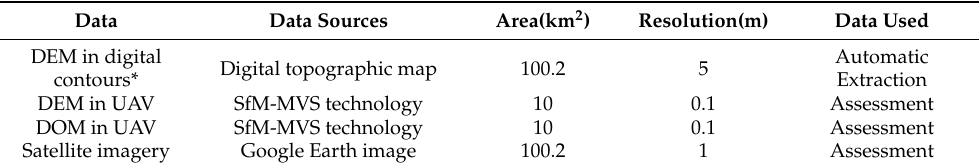
Table 1. Study area data types and description.